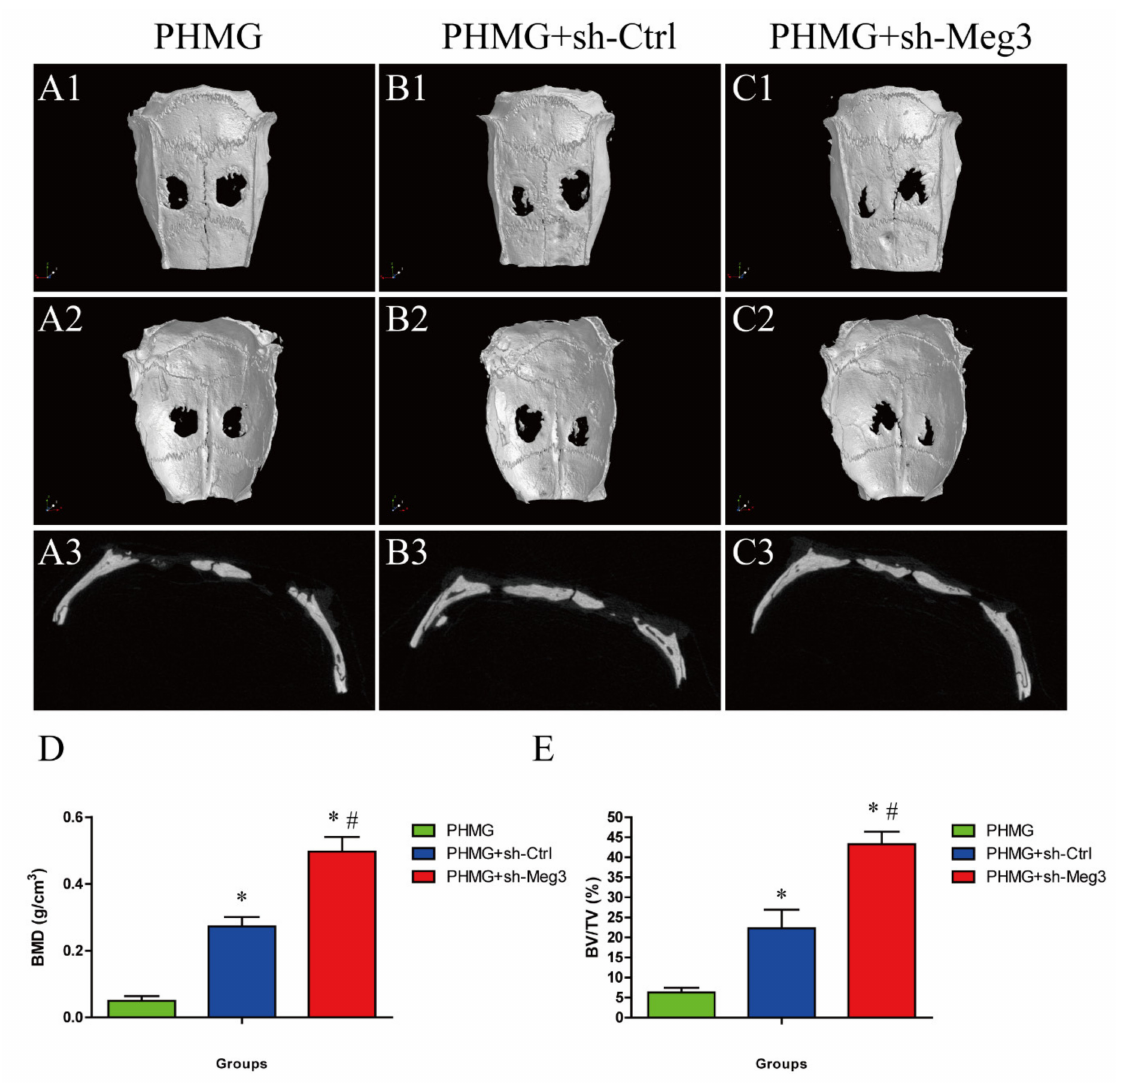
Figure 5. MEG3 knockdown in BMSCs promoted bone repairing in vivo. ( A1 – C3 ) Representative micro-CT images show the bone repairing in PHMG, PHMG + sh-Ctrl and PHMG +sh-Meg3 groups at 8 weeks. Bar graph shows quantitative analysis of micro-CT vessel volume in each group. Morpho- metric analysis of BMD ( D ) and BV/TV ( E ) as determined by micro-CT for each group at 8 weeks. * p < 0.05 versus the PHMG group, # p < 0.05 versus PHMG + sh-Ctrl group. ( n =